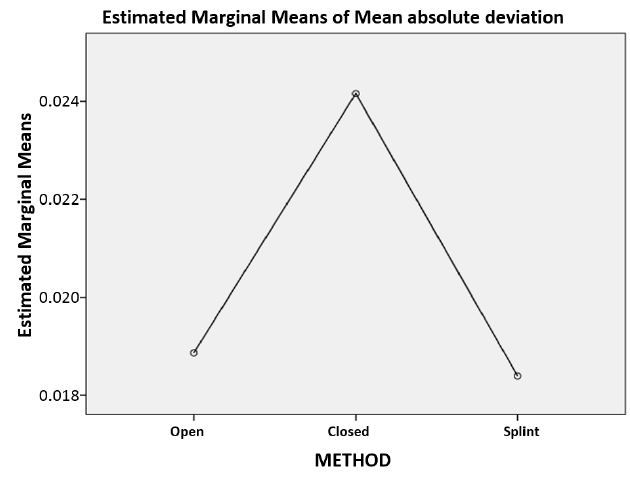
Figure 18. Mean absolute deviation (mm) according to the impression method.